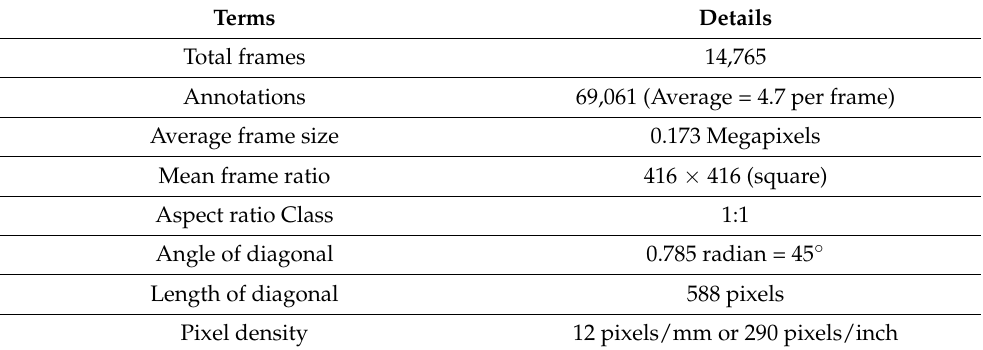
Table 4. Arithmetical details of training frames in S-BIRD after preprocessing and augmentation.